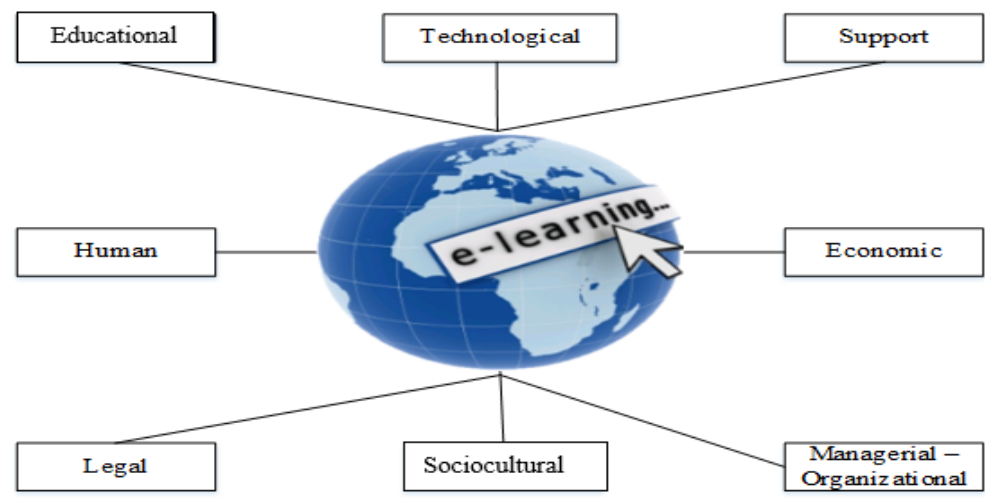
Figure 3. Challenges of the Iranian e-learning